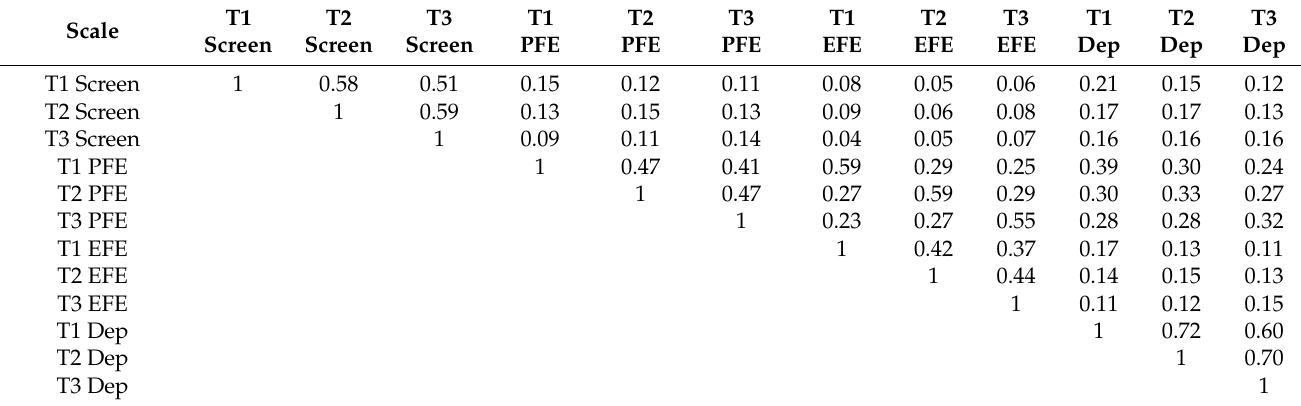
Table A2. Pearson correlations between screen time (Screen), problem-focused coping (PFE), emotion- focused coping (EFE) and depression (Dep) at each timepoint (T1, T2, T3). Results for the pooled multiple imputation datasets (N = 4793). All correlations are significant at the 0.01 level (two-tailed), except for four Screen-EFE correlations, which are significant only at the 0.05 level (T1 Screen ×